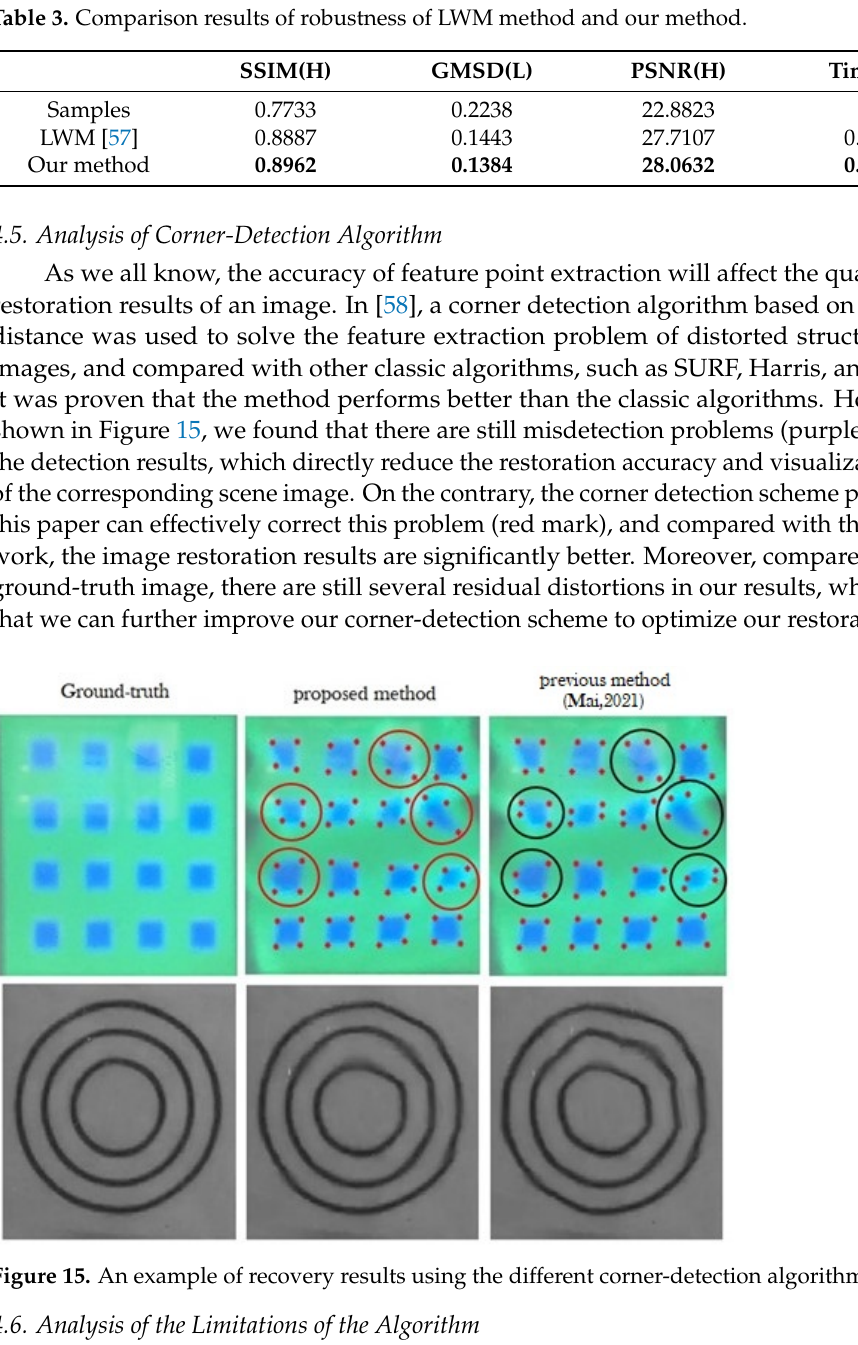
Figure 16. Recovery result of a sampled frame using the proposed method.